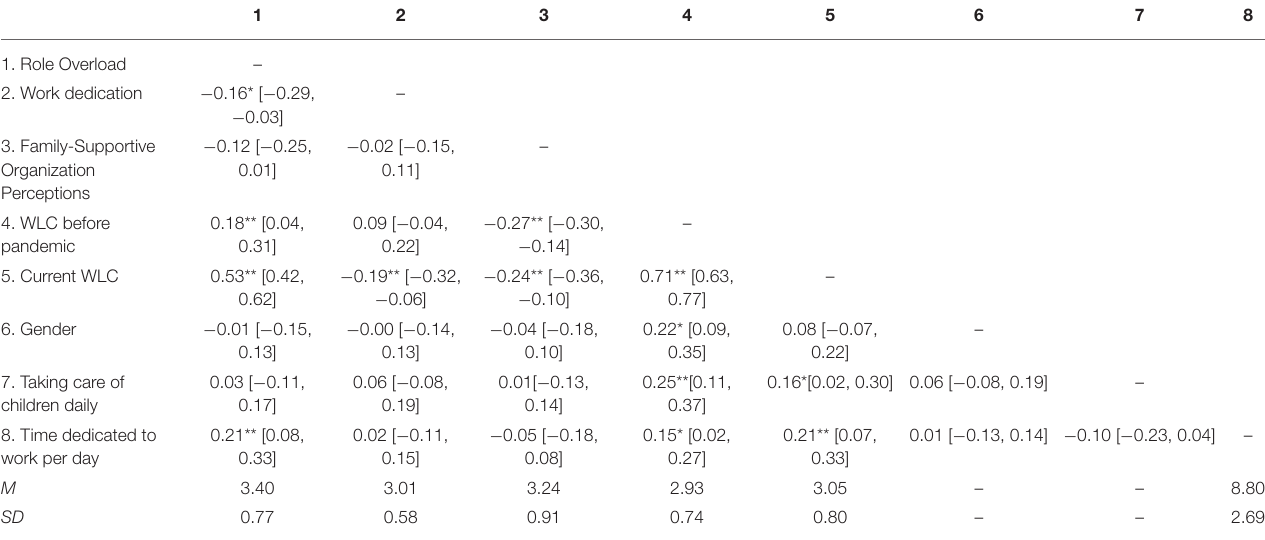
TABLE 2 | Descriptive statistics, and correlations [confidence intervals] between the study